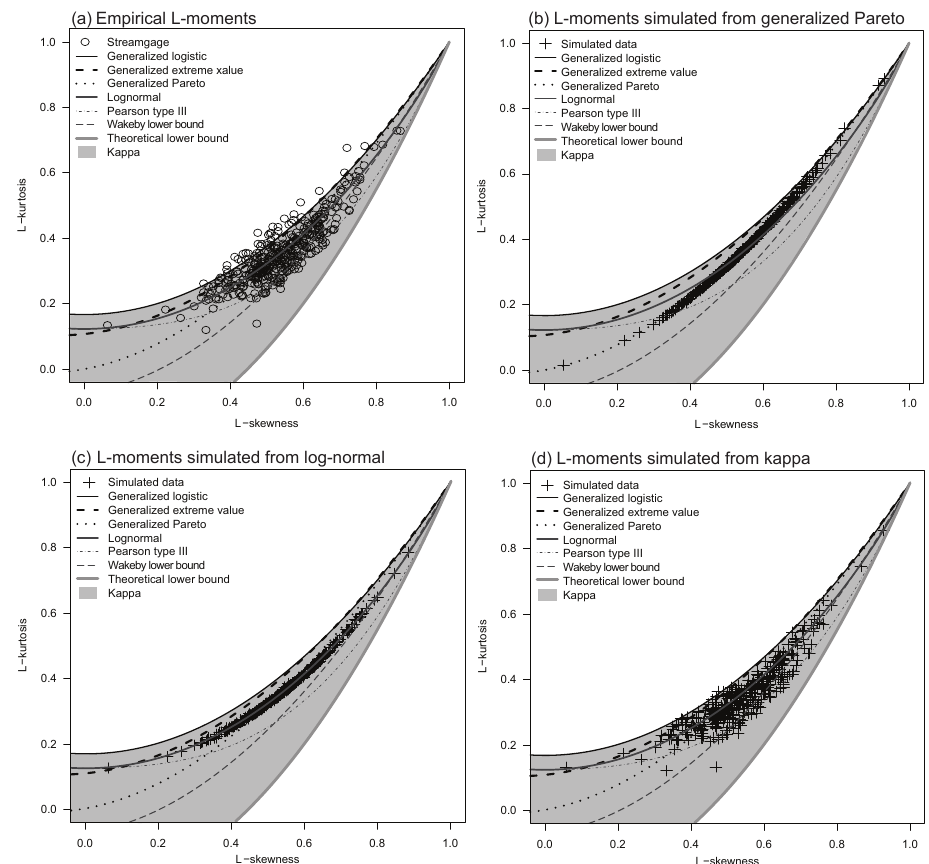
Figure 2. Theoretical L -skew and L -kurtosis ratios of three- and four-parameter distributions compared to empirical L -skew and L -kurtosis ratios from (a) daily streamflows at 420 US sites, (b) flows simulated from three-parameter generalized Pareto, (c) flows simulated from three-parameter lognormal, and (d) flows simulated from four-parameter kappa